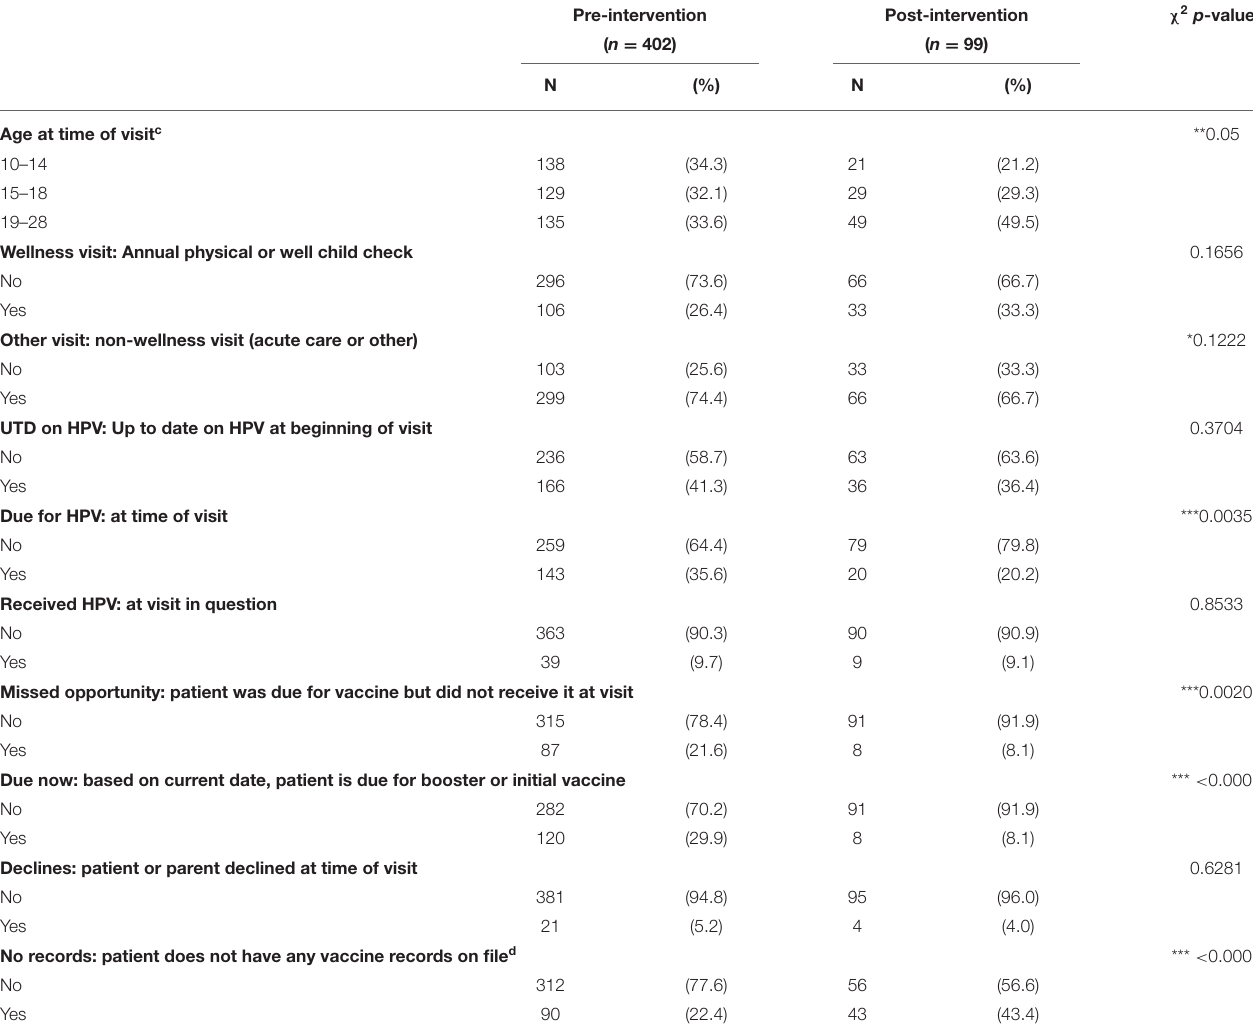
TABLE 1 | Cross sectional review of human papillomavirus (HPV) vaccination at Telluride Medical Center (TMC) pre- and post- intervention, 2019–2021 a . Pre-intervention